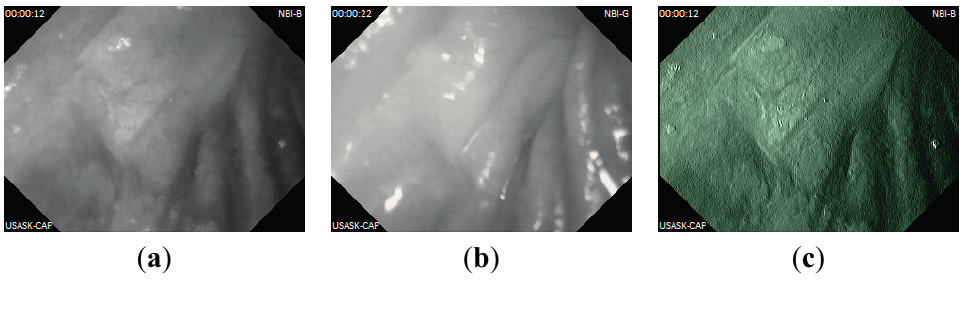
Figure 15. Captured NBI images from live pig’s intestine: ( a ) grayscale image with blue light, CR = 84.20%; ( b ) grayscale image with green light, CR = 84.01%; ( c ) Combined pseudo color NBI image from (a) and